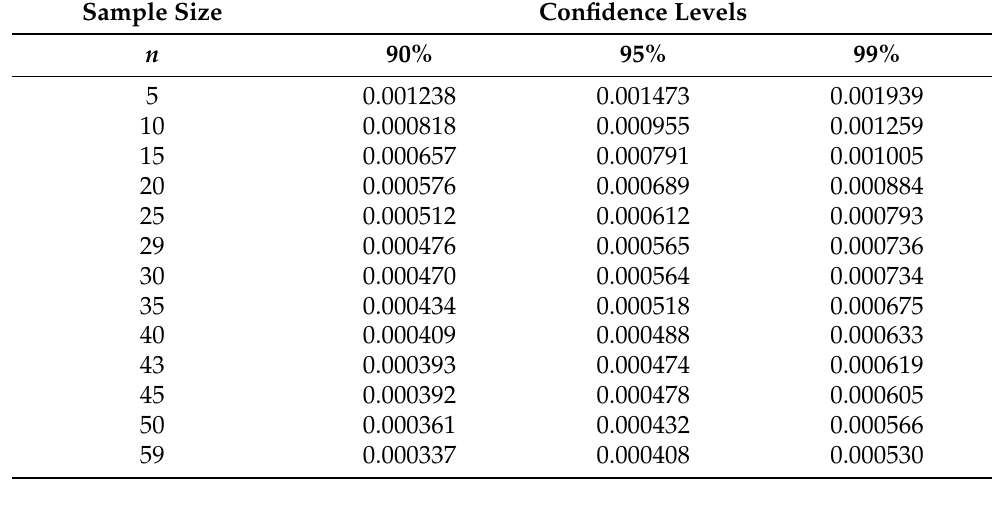
Table 2. Critical values of the statistic ˆ ∆ ( 0.99 ) .